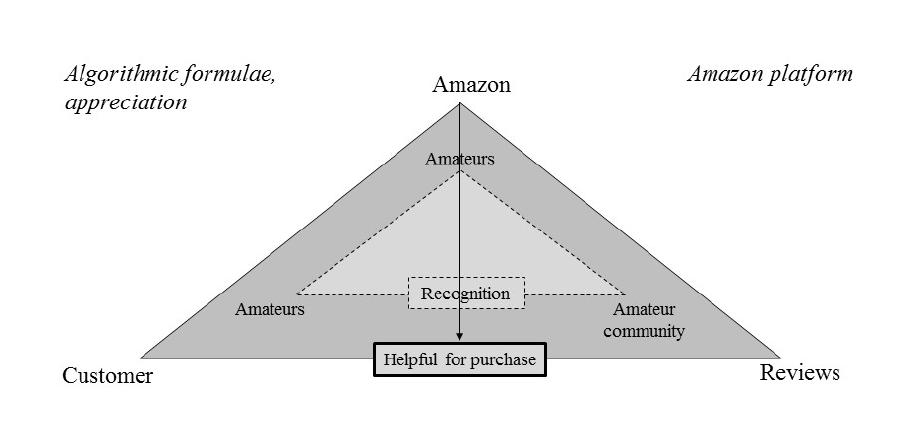
Figure 7 Valuations of reviews on Amazon.com Source: Authors’